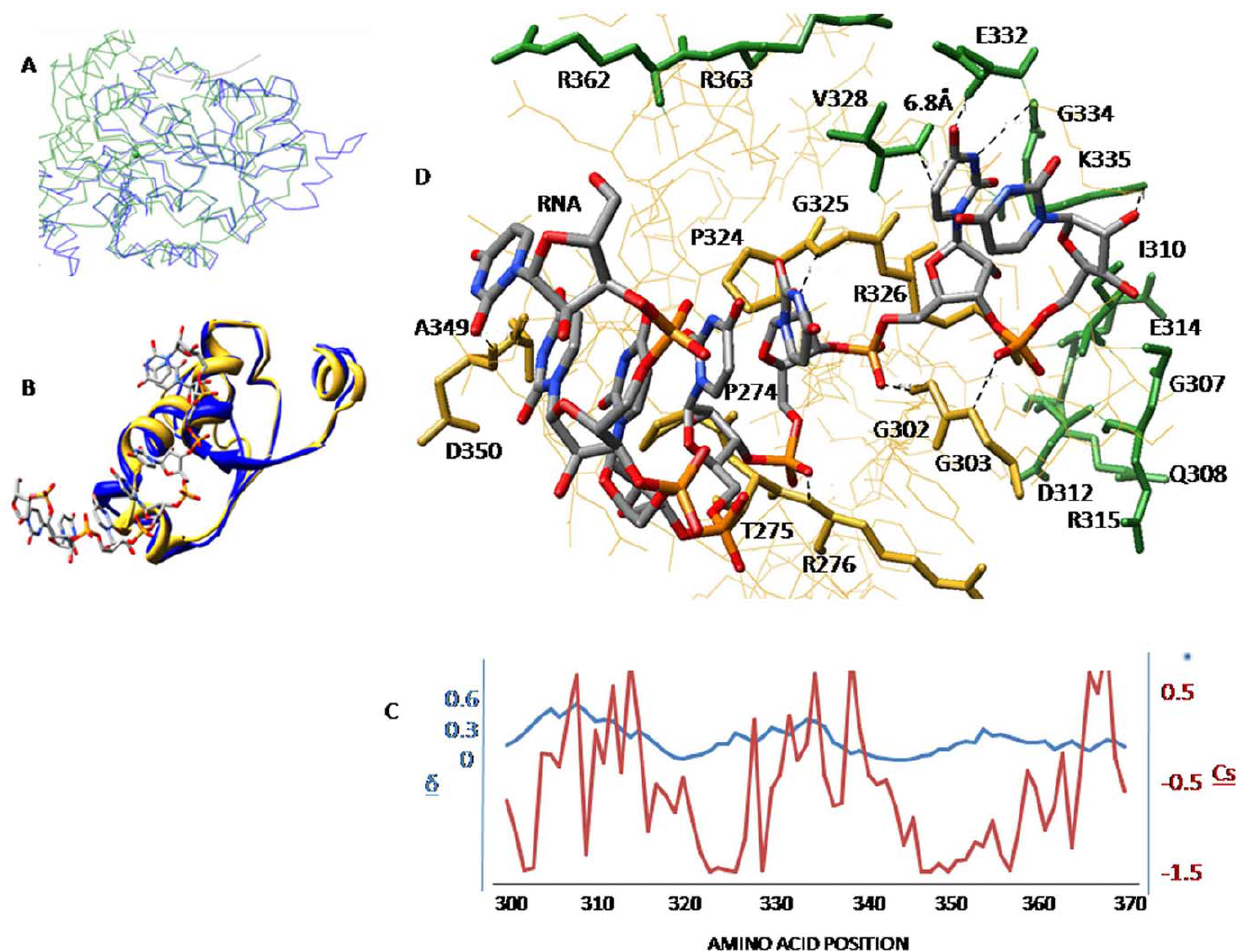
Figure 5. Functional residues at the RNA binding site. A) Structural alignment of C alpha traces of DDX3X and DDX4. B) RNA binding region of DDX3X structurally alignment with DDX4 (RMSD=0.4). C) Plot of normalized C alpha displacements with conservation scores to identify flexibility of functional residues at this region. D) Flexible (green) and rigid (yellow) functional residues identified at the RNA binding region of DDX3X.